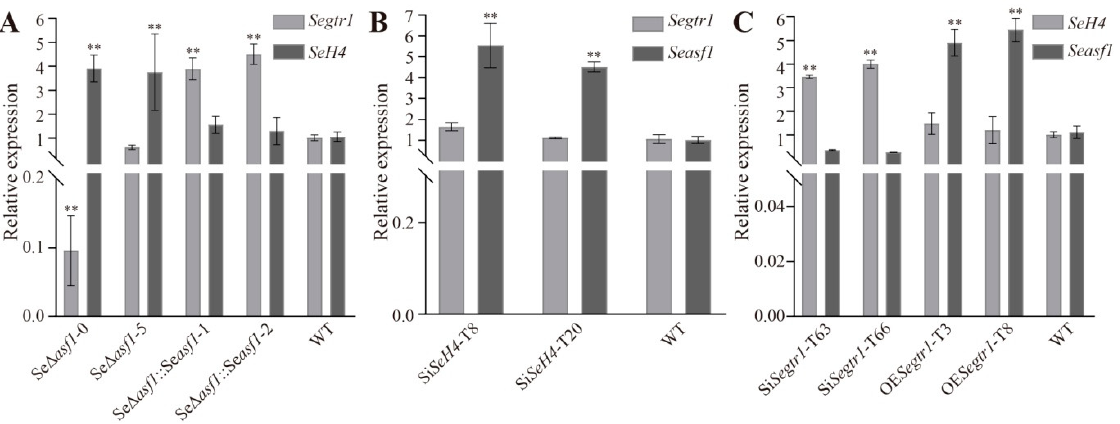
Figure 4. The expression patterns of Seasf1 , SeH4 , and Segtr1 in knockout mutants, silenced lines or overexpression strains. ( A ) The expression levels of Segtr1 and SeH4 in two Se ∆ asf1 mutants and two complemented transformants were measured by qRT-PCR. ( B ) The expression levels of Segtr1 and Seasf1 in two Si SeH4 lines were measured by qRT-PCR. ( C ) The expression levels of Seasf1 and SeH4 in two Si Segtr1 lines and two OE Segtr1 lines were measured by qRT-PCR. The degree of WT was assigned to value 1.0. Two Seasf1 deleted mutants were Se ∆ asf1 -0 and Se ∆ asf1 -5, two comple- mented transformants were Se ∆ asf1 :: Seasf1 -1 and Se ∆ asf1 :: Seasf1 -2. Two SeH4 -silenced lines were Si SeH4 -T8 and Si SeH4 -T20. Two Segtr1 -silenced lines were Si Segtr1 -T63 and Si Segtr1 -T66, two OE- Segtr1 lines were OE Segtr1 -T3 and OE Segtr1 -T8. The Actin in S. eturmiunum was used as endoge- nous control. The bars indicated statistically significant differences (ANOVA; ** p < 0.01). 2.4. SeASF1 Interaction with SeH4, and SeGtr1 Interaction with SeASF1 and SeH4 To test whether can occur the interaction between SeASF1 and SeGtr1, SeH4 and SeGtr1. Y2H revealed that SeASF1 interacted with SeH4, and SeGtr1 interacted with SeASF1 and SeH4 (Figure 5A). On the basis of GST pull-down, SeASF1 was specifically interacted with SeH4 (Figure 5B), while SeGtr1 could interact with SeASF1 and SeH4, respectively (Figure 5C). To further assure those results of the Y2H and pull-down ex- periments, SeASF1-GFP and SeH4-Flag, SeGtr1-Flag and SeASF1-GFP, and SeGtr1-Flag and SeH4-GFP were expressed in F. graminearum protoplasts, respectively, and then the immune complexes were estimated using Co-IP assays (Figure 5D,E). Thus, SeASF1 in- teracted with SeH4, and SeGtr1 interacted with SeASF1 and SeH4. Altogether, SeGtr1 could cooperate with SeASF1 and SeH4 to modulate asexual development of S. eturmi- unum .